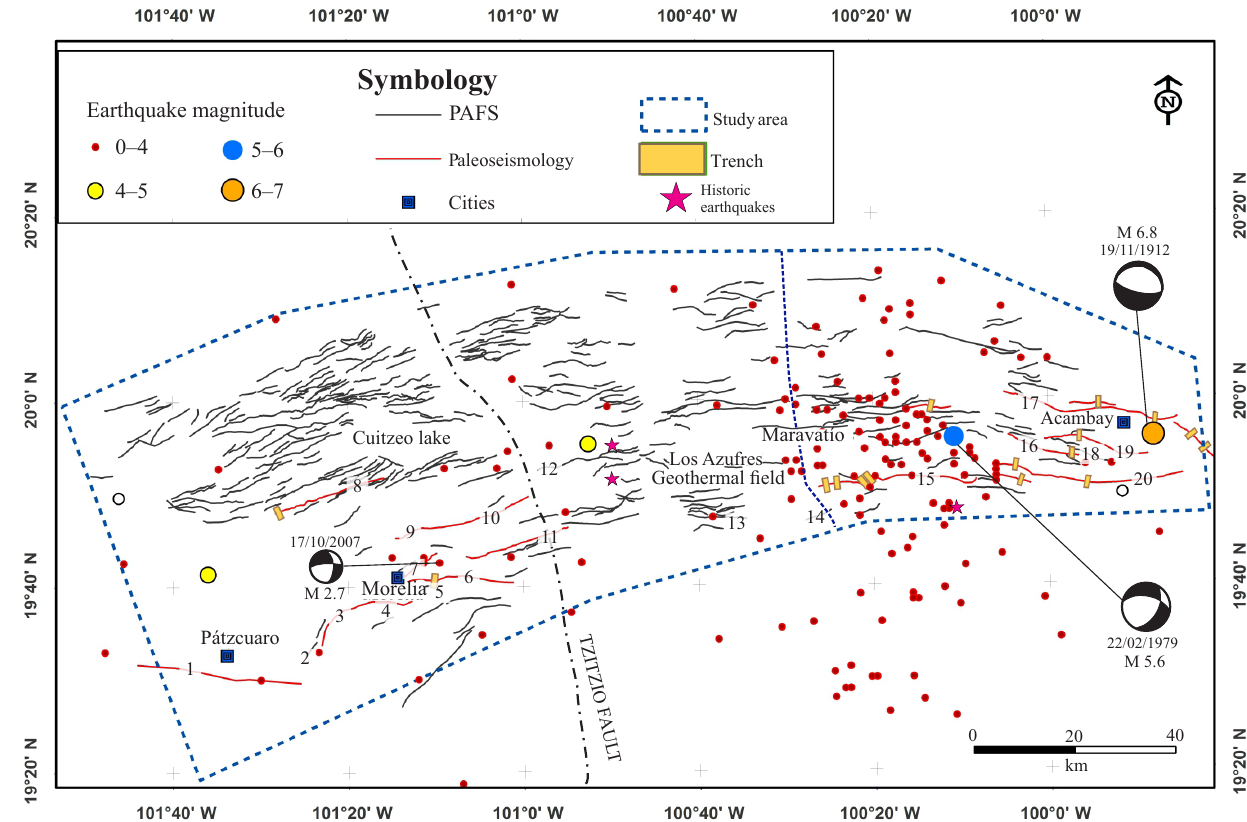
Figure 2. Structural map of the Pátzcuaro–Acambay fault system. Active faults are represented by continuous black lines. Continuous red lines are the faults studied with paleoseismological approach. The purple dotted line is the limit between the central and eastern zones and the Tzitzio fault is the limit between the western and central zones. Stars represent the seismic crisis in Pátzcuaro and Araró (in 1845 and 1858) and Zinapécuaro and Tlalpujahua (in the 19th century). Circles represent the seismicity from 1912 to 2018 based on the catalog of the National Seismological Service of Mexico (Servicio Sismológico Nacional, SSN). Focal Mechanisms were reported by Astiz-Delgado (1980), Suter et al. (1992, 1995), Langridge et al. (2000), Singh et al. (2011, 2012), and Rodríguez-Pascua et al. (2012). The ascending numbers are referred to in Table